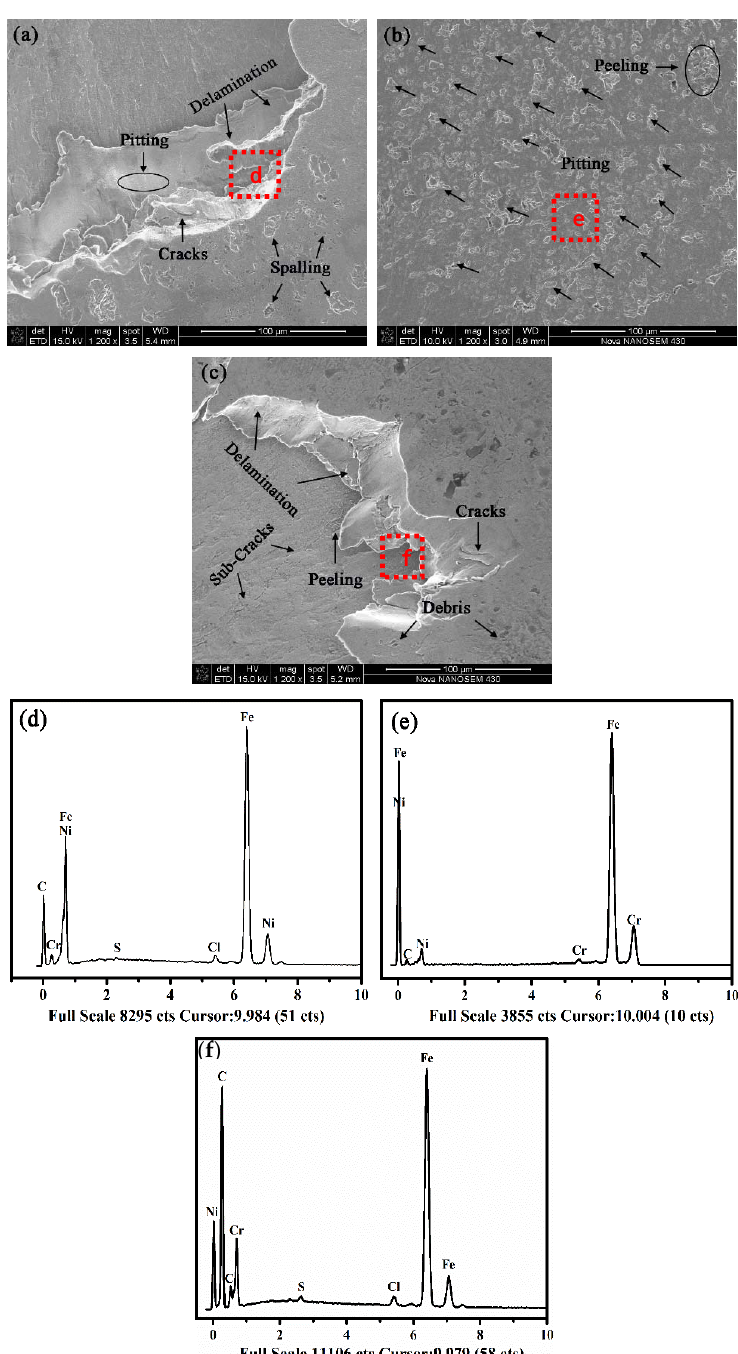
Figure 8. Typical micrographs of the damage: ( a ) Quenched at 900 °C contact stress3.2 GPa and 543,400 cycles to failure; ( b ) Quenched at 1000 °C contact stress 3.2 GPa and 572,000 cycles to failure; ( c ) Quenched at 1100 °C contact stress 3.2 GPa and 566,000 cycles to failure and EDS graphs at different temperatures of ( d ) 900 °C, ( e ) 1000 °C, and ( f ) 1100 °C.